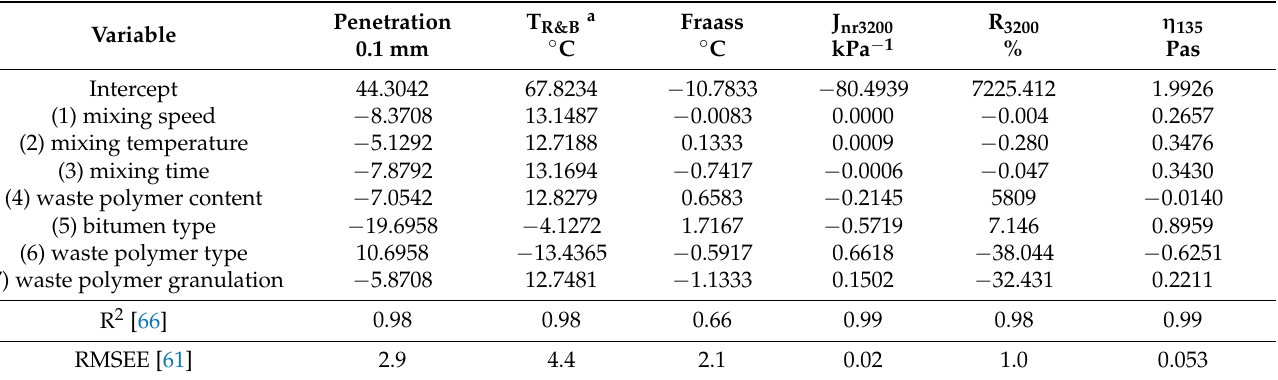
Table 6. Linear regression model parameters.